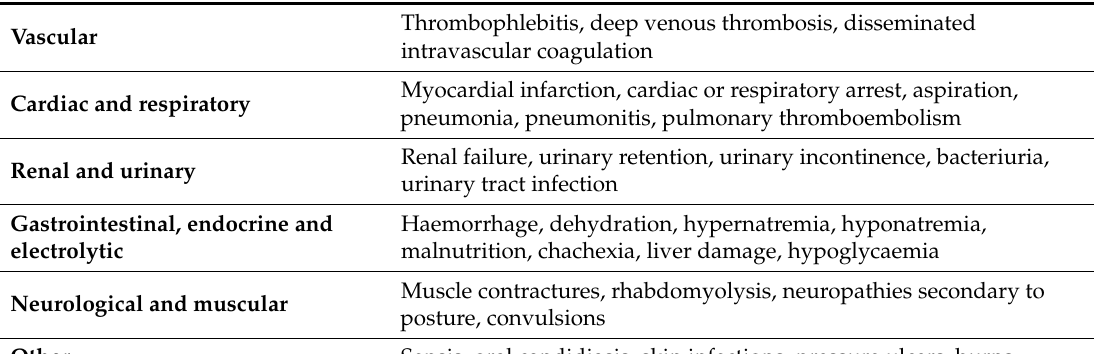
Table 3. Common complications in Catatonia